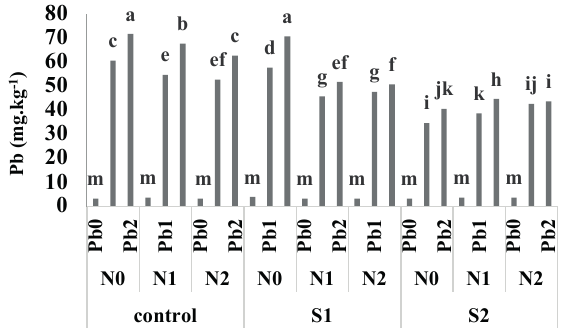
Figure 1. Lead (Pb) content in Japanese raisin in response to salin- ity (S0: Control, S1: 3 and S2: 6 dSm -1 ), nitrate (N0: 0, N1: 30 and N2: 60 mgL -1 ), and Pb (Pb0: 0, Pb1: 300 and Pb2: 600 mgL -1 ).